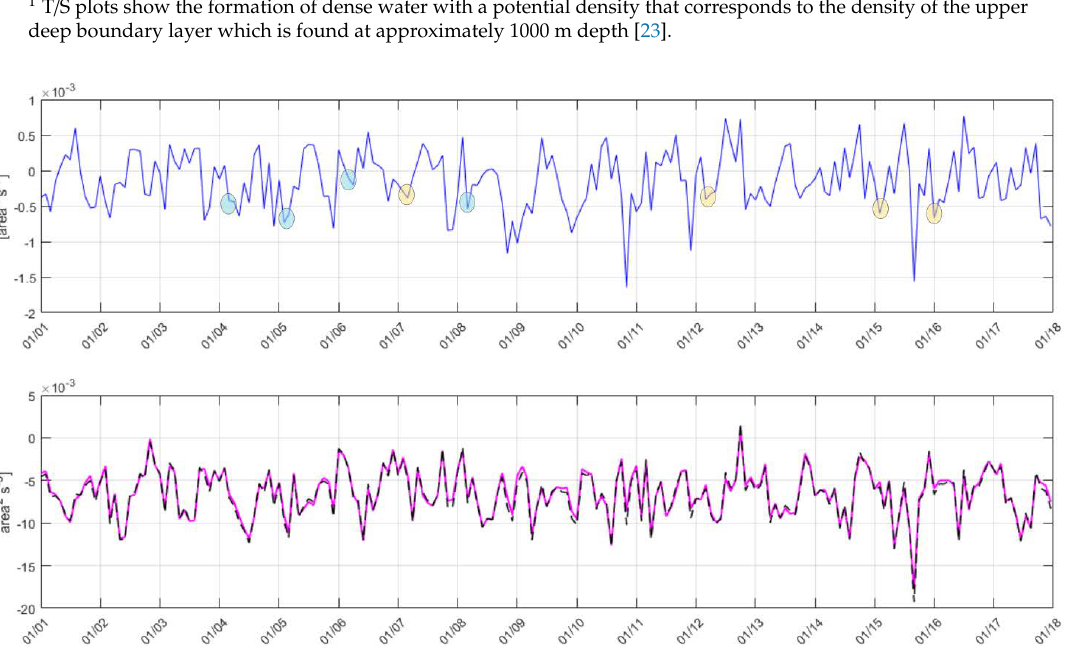
Figure 5. Climatology of monthly integrated heat fluxes for the center of RG from 2001 to 2017. Main heat losses generally occur in November and December (turquoise bars) and initiate the preconditioning phase. Subsequent heat losses in January, February, and March induce dense water formation.